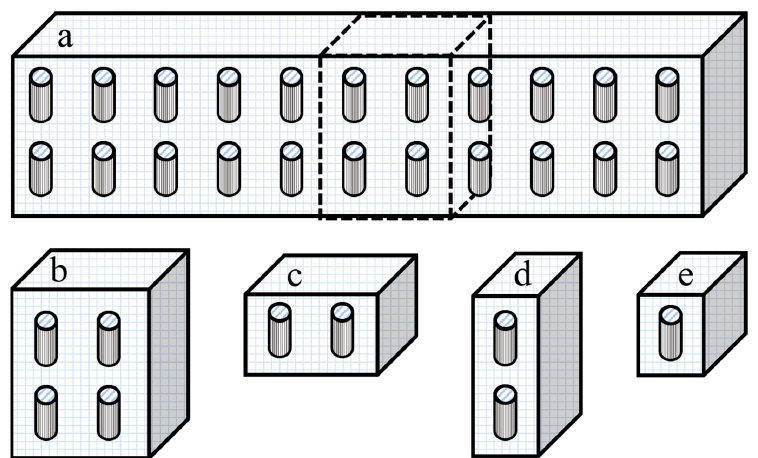
Figure 3. ( a ) A schematic diagram of a cross-section of the MMM showing a series of repeatable unit elements. A series of smaller membrane cross-sections: ( b ) four unit elements with vertical nanotubes (Case I), ( c ) two unit elements with vertical nanotubes distributed on the x -axis (Case II), ( d ) two unit elements with vertical nanotubes distributed on the y -axis (Case III), and ( e ) one unit element with a vertical nanotube at the center of the element (Case Table 2. Dispersed and continuous phase specifications, which are representative of single-wall carbon nanotubes.